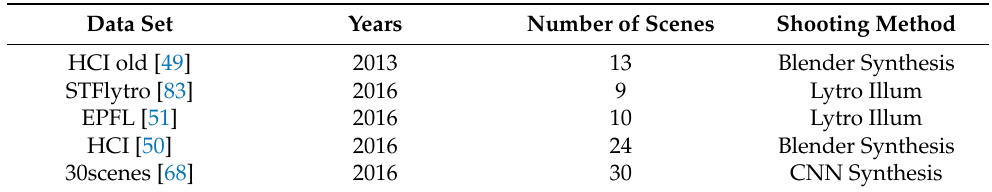
Table 2. Overview of the light field super-resolution data sets.